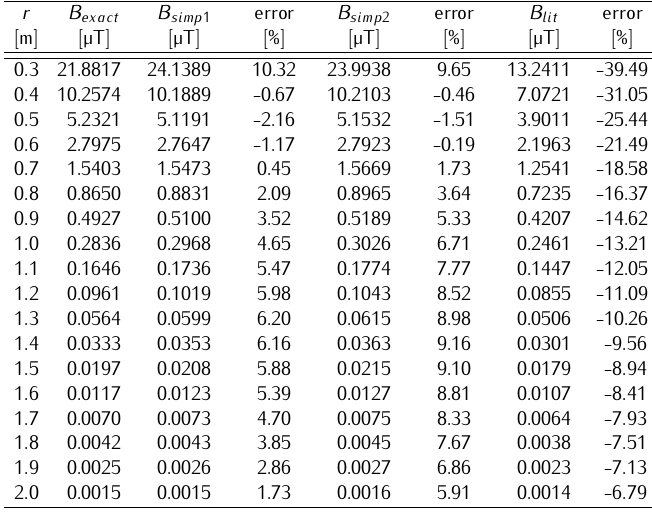
Table 1. B exact , B simp 1 , B simp 2 , B lit vs. distance r from the axis of the helix and relevant percent errors with respect to B exact for the cable ARE4H1R